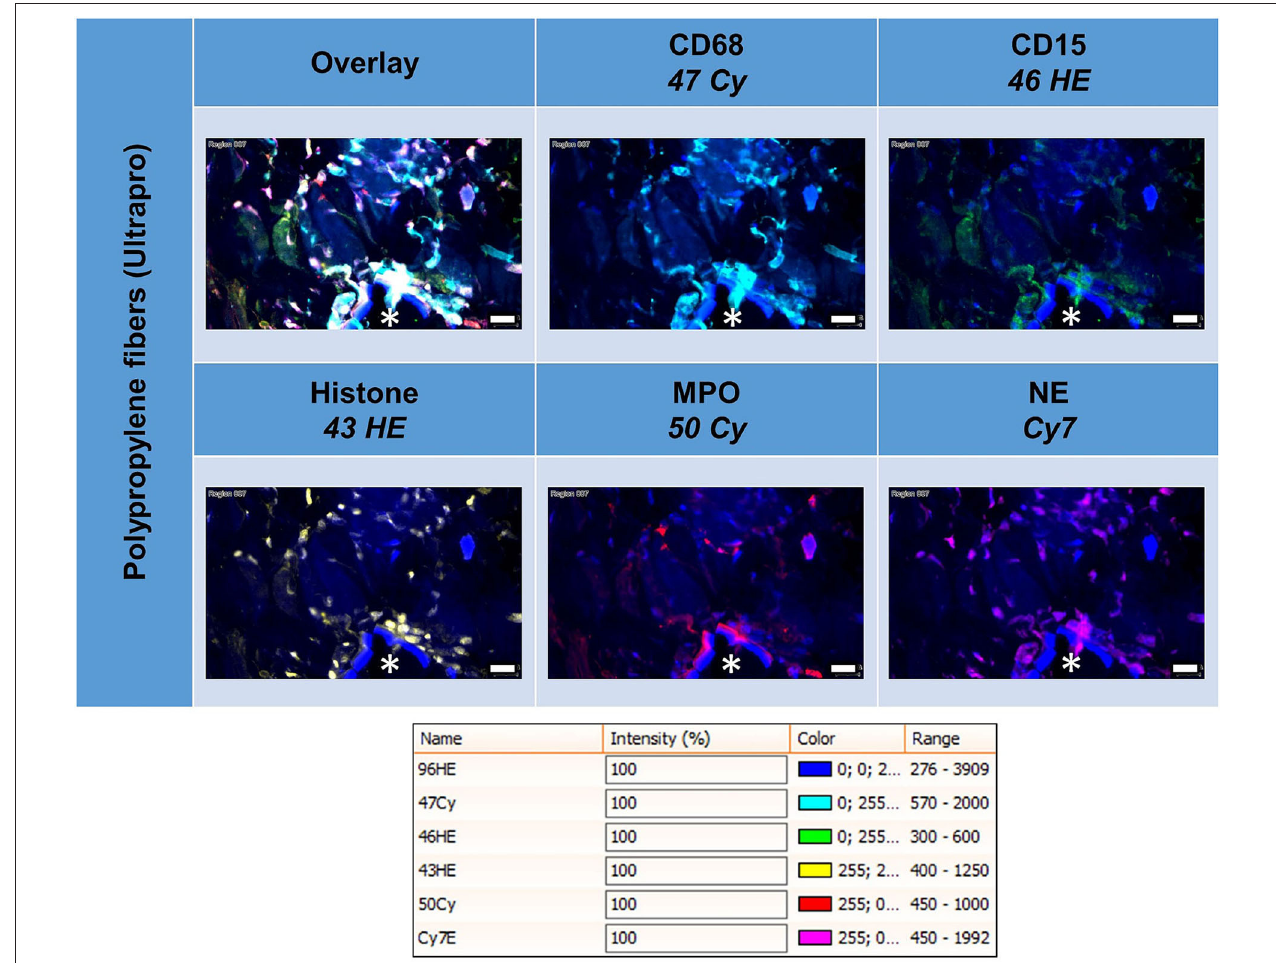
FIGURE 8 | Tissue section of infected composite PP mesh labeled for nuclei with DAPI (blue), macrophages with CD68 (turquoise), neutrophils with CD15 (green), histone (yellow), myeloperoxidase (MPO, red), and neutrophil elastase (NE, magenta). EDAs indicate the presence of neutrophil extracellular traps (NETs). Asterisk marks a fiber location, scale bars = 50 µ